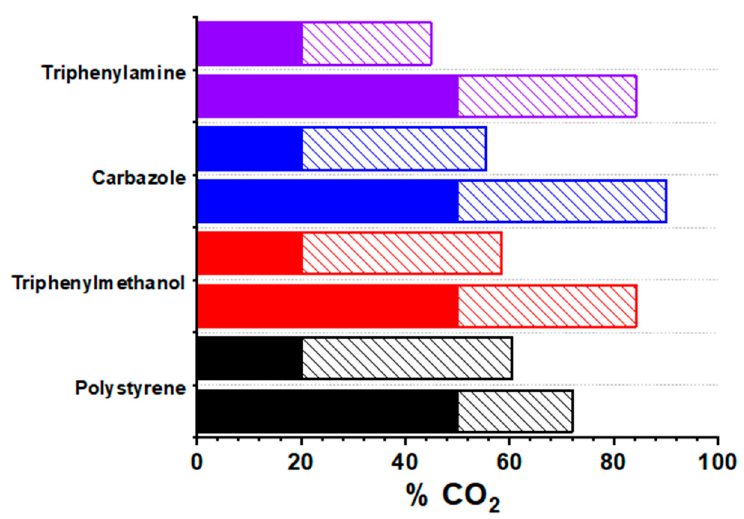
Figure 5. CO 2 concentration of the input gas (solid bar) and the output exhaust gas stream at 1 bar (dashed bars) at 40 °C.